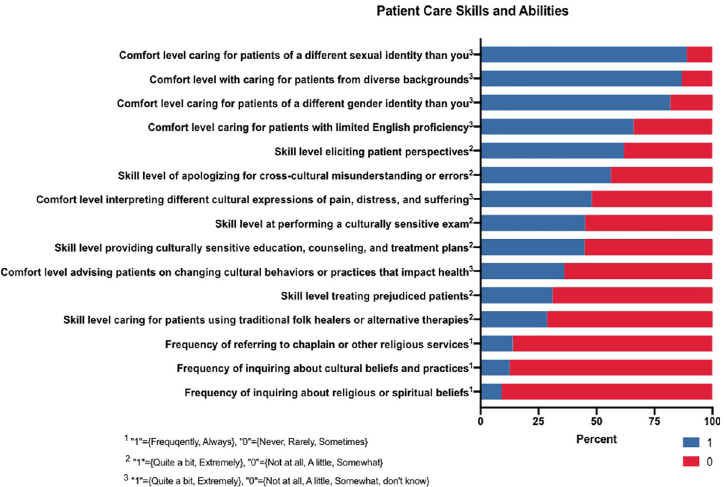
Fig 2. Patient care skills and abilities results. 1 “1” = {Frequently, Always}, “0” = {Never, Rarely, Sometimes}. 2 “1” = {Quite a bit, Extremely}, “0” = {Not at all, A little, Somewhat}. 3 “1” = {Quite a bit, Extremely}, “0” = {Not at all, A little, Somewhat, don’t